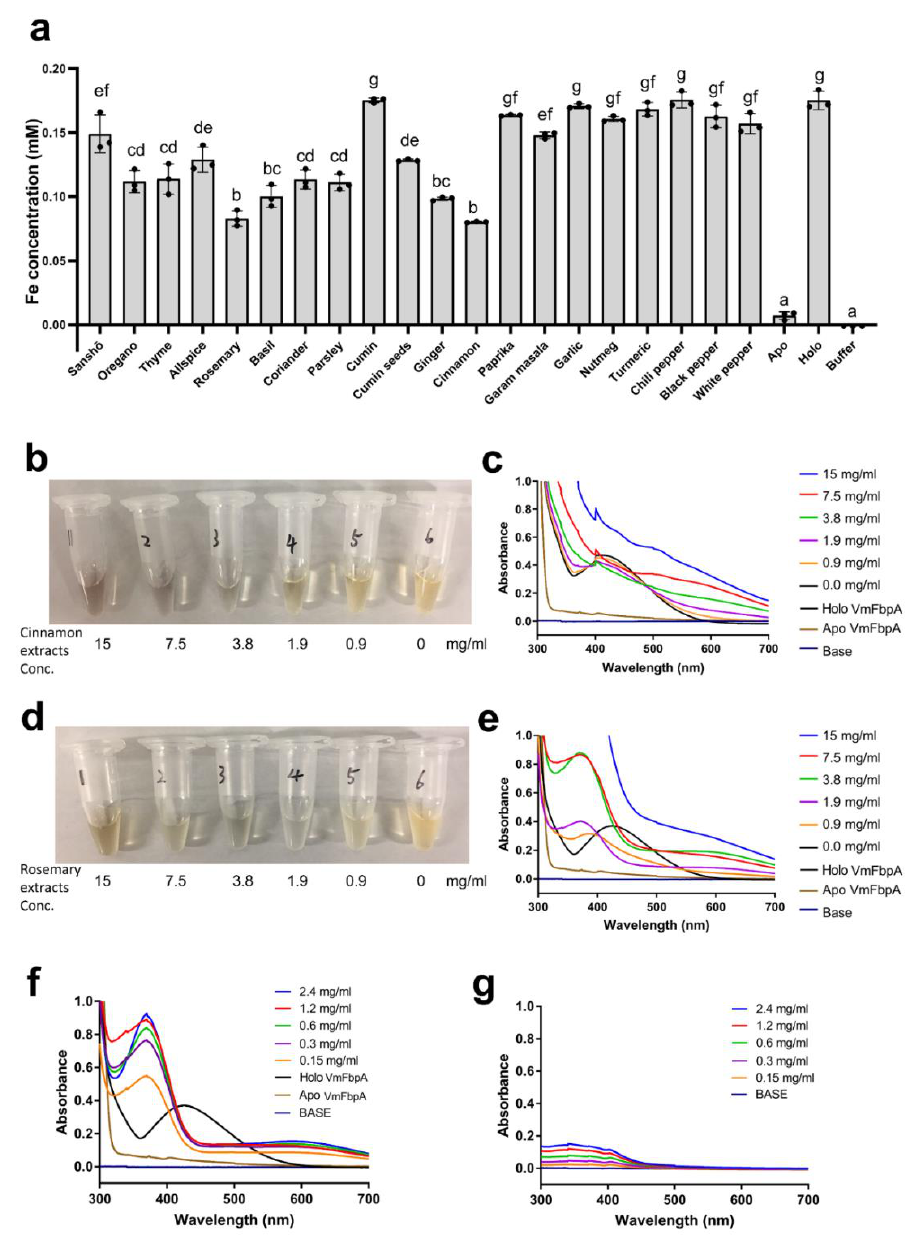
Figure 1. ( a ) Screening of VmFbpA inhibitors for Fe 3+ binding. The gray bar represents the remaining Fe concentration after treatment with the extracts of 20 spices; 10 mM EDTA was used as the negative control. In addition, apo VmFbpA (Apo) and Fe 3+ -VmFbpA (Holo) were also measured for comparison. Buffer represents the gel filtration buffer (50 mM Tris-HCl (pH 8.0), 50 mM NaHCO 3 , and 150 mM NaCl) used in VmFbpA purification. Data are means ± SD. Means with the same letter are not significantly different from each other ( p < 0.05) ( b ) Eluents after inhibition assays using cinnamon extracts. ( c ) Absorbance spectra (300 – 700 nm) of the respective eluents shown in ( b ). ( d ) Eluents after inhibition assays using rosemary extracts. ( e ) Absorbance spectra (300 – 700 nm) of the respective eluents shown in ( c ). Spectra of apo and Fe 3+ -VmFbpA (controls). ( f ) Absorbance spectra (300 – 700 nm) of RA binding to apo VmFbpA. ( g ) Absorbance spectra (300 – 700 nm) of RA only. Base is elution buffer containing 50 mM Tris-HCl (pH 8.0), 50 mM NaHCO 3 , 150 mM NaCl, and 250 mM imidazole.